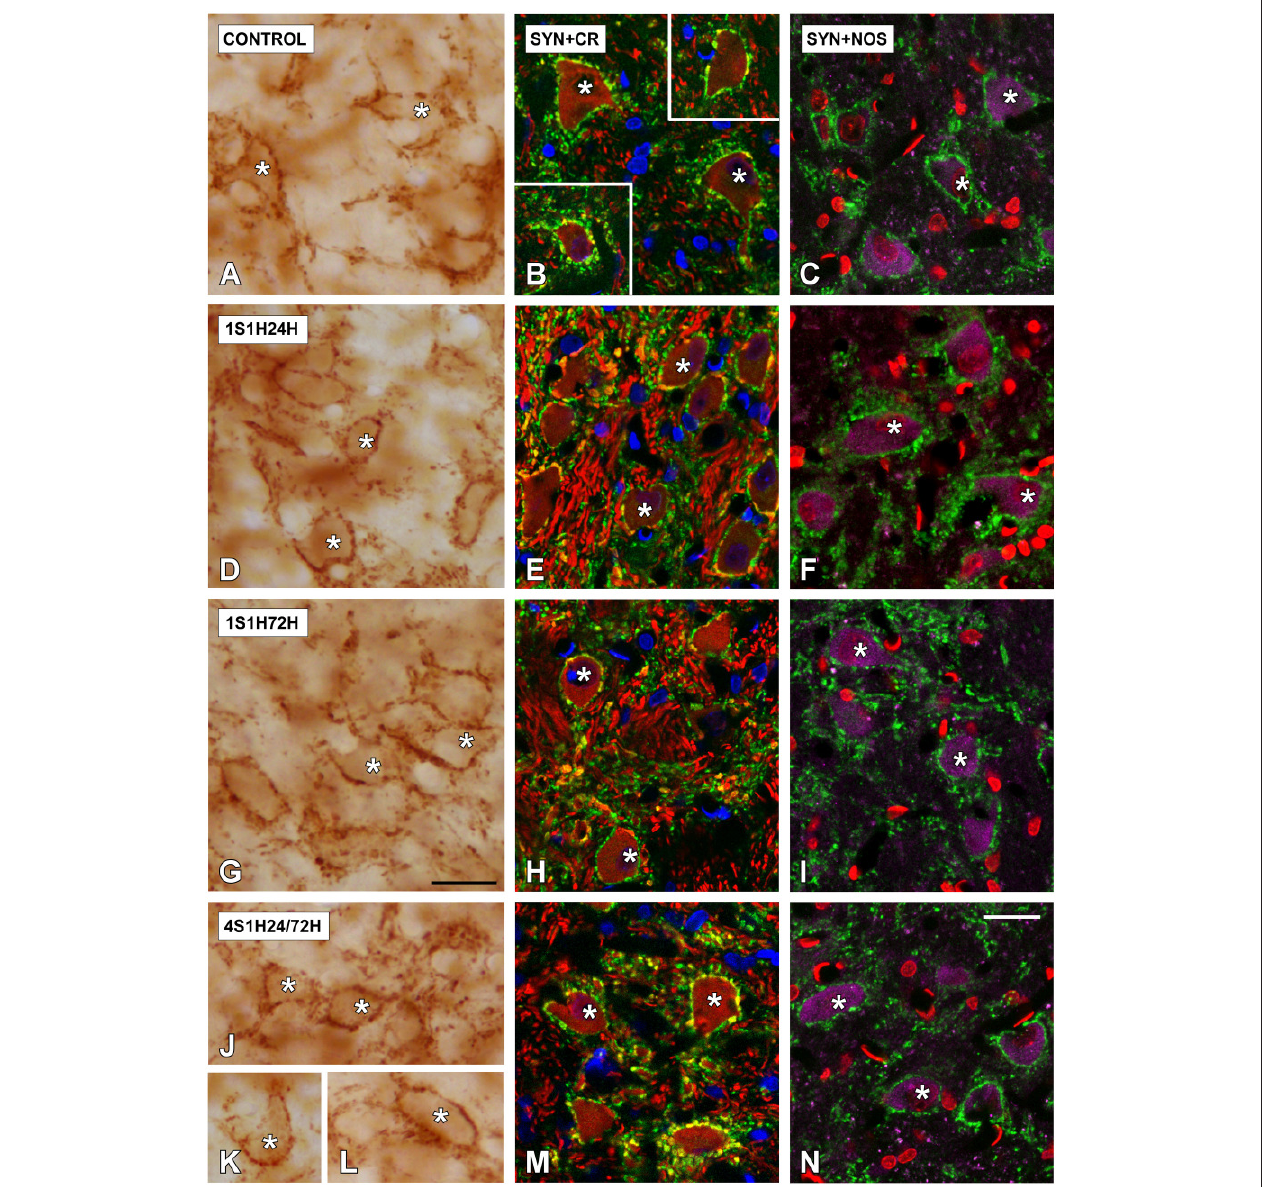
FIGURE 13 | Digitized high magnification images depicting SYN immunostaining in the PVCN in control and noise-exposed rats. Stained endings mainly distributed around either CR or NOS immunostained cochlear nucleus neurons (asterisks in A–N ). The distribution pattern of SYN immunostaining was not different among groups. Note that there was an upregulation in NOS and CR staining by 24h after the first session (D–F) . Scale bars represent 25 µ m in (G,N)